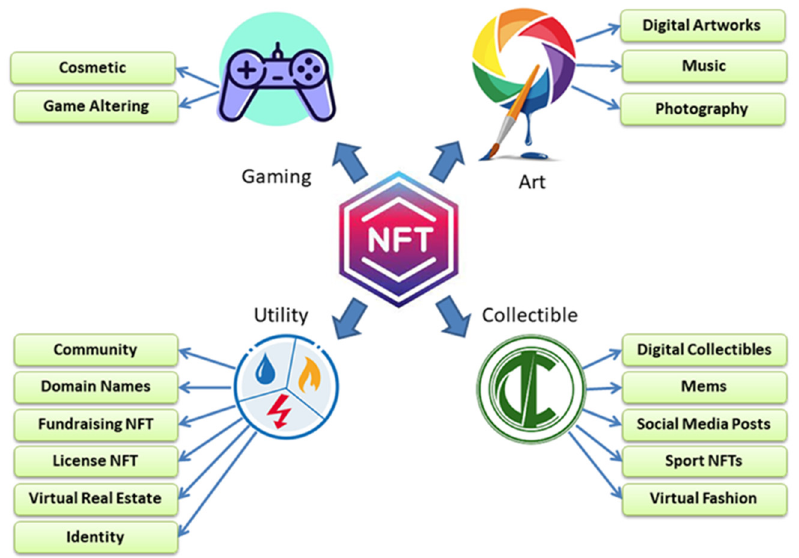
Figure 1. Classes of digital assets.